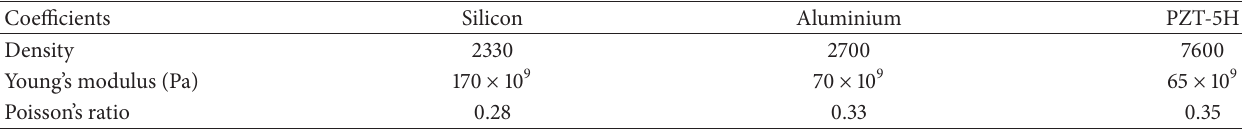
Table 2: Material properties.